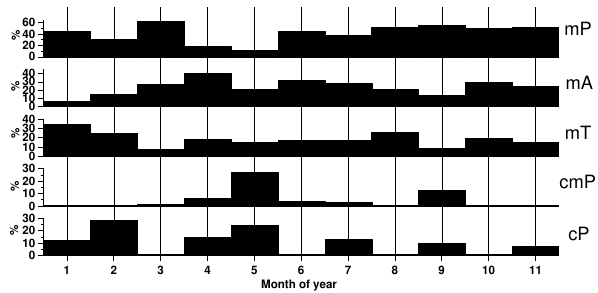
Fig. 2. Occurrence (%) of the five different air mass back trajec- Figure 2. Occurrence (%) of the five different air mass back trajectories type described in tories type described in Dall’Osto et al. (2010) for each of the 11 Dall’Osto et al (2010) for each of the 12 months during the 2008 EUCARRI year. months during the 2008 EUCARRI